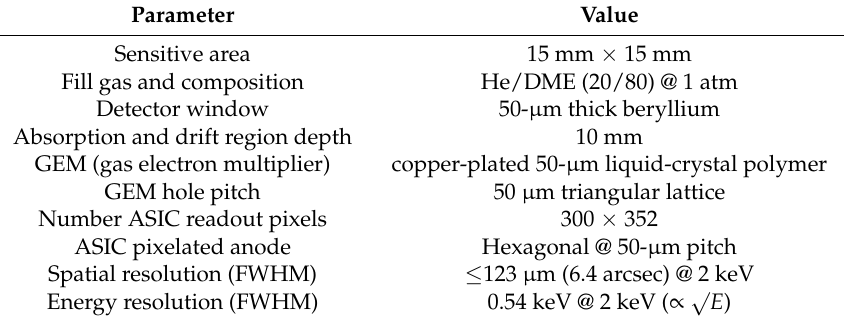
Figure 14. ( Left ) The modulation factor, µ , as a function of energy. The solid line is based on Monte- Carlo simulations. The colored symbols are based on measurements at different times. The dotted lines are simple linear connections; ( upper right ) Measurements of a 99%-polarized source at 3.7 keV; ( lower right ) Measurements of an unpolarized source at 5.9 keV.